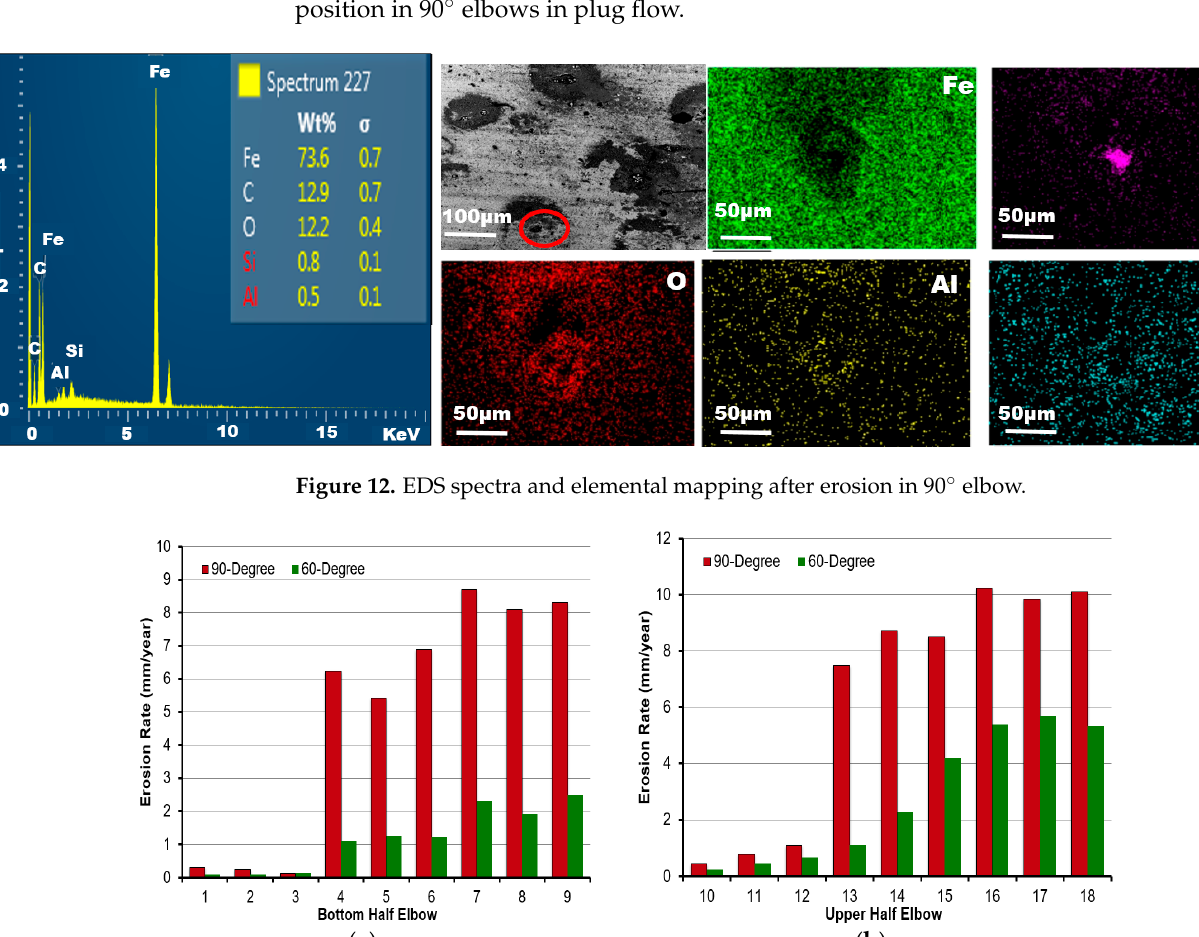
Figure 14. Microhardness of carbon steel elbows’ upper half sections before and after the test. 4. Conclusions This paper investigated the influence of elbow angle on the erosive behavior of carbon steel due to the impaction of silt particles in plug flow conditions. A total of 36 specimens were cut from the upper and bottom halves of the 90° elbow and the 60° elbow at various locations. Moreover, a paint removal method, mass loss analysis, microscopic imaging, surface roughness evaluation, and microhardness analysis were employed to